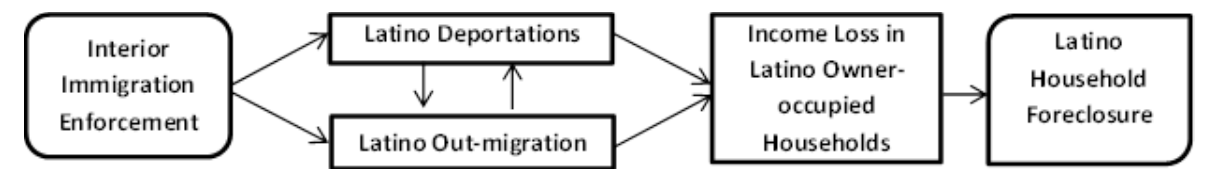
Figure 2: Conceptual model of Latino deportations and Latino household